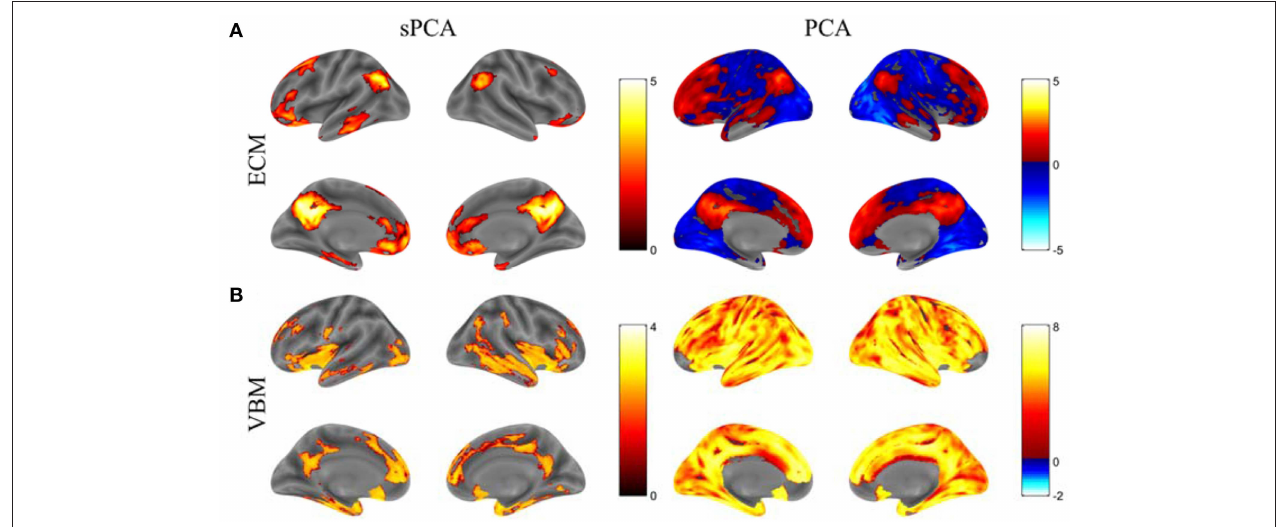
FIGURE 5 | The standardized principal component maps having largest variance from sPCA and PCA. (A) ECM principal component, (B) VBM principal component.